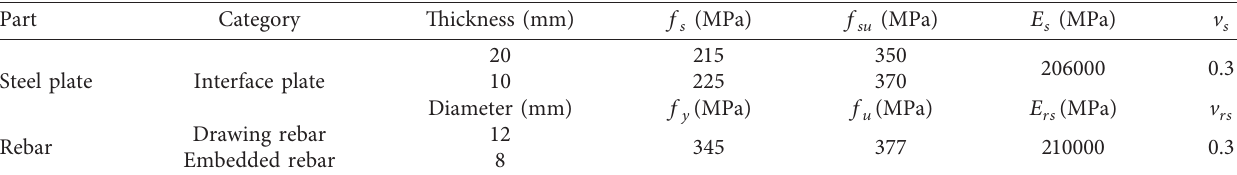
Table 3: Mechanical properties of steel plate and rebar.